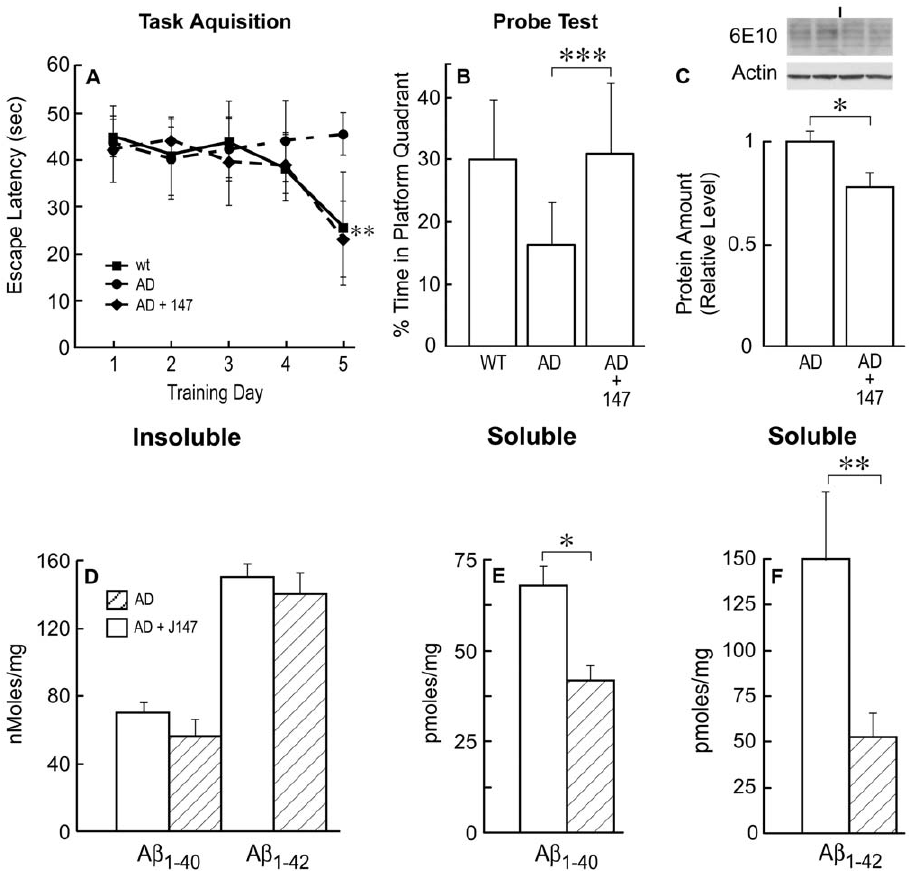
Figure 5. J147 Improves Learning and Short-Term Spatial Memory. Line 85 mice were fed J147 at 200 ppm between 3 and 10 months of age and then assayed for learning and memory in the Morris water maze. (A) Task acquisition phase. Data are expressed as standard deviation 6 SEM and analyzed by ANOVA of repeated measures. F(2,14)=8.3. ** P , 0.01 AD vs AD + J147; P , 0.05 AD vs. control. (B) Probe test. One-way ANOVA F(2,54)=16.6. ** P , 0.001 AD vs AD + J147; P , 0.05 AD vs. control. These data show that both wild type and line 85 mice are slow learners, but that J147 corrects the deficit in both learning (day 5) and their spatial memory (probe test). (C) A b oligomers between 30 and 50 kD in soluble fraction from AD (left 2 lanes) and AD + J147 (right 2 lanes) animals. J147 treatment decreased these oligomers. Two-tailed P value, * P , 0.05. A b 1–40 and A b 1–42 levels were measured by ELISA in control AD animals (open bars) and AD animals fed J147 (hatched bars) in the insoluble (100,000 6 g pellet) (D) and RIPA soluble fractions (E and F). J147 treatment decreased both soluble A b 1–40 and A b 1–42 levels. Two-tailed P values * P , 0.05; ** P , 0.01; *** P , 0.001. All data shown are means 6 SEM. n=6 to 9 mice per group.